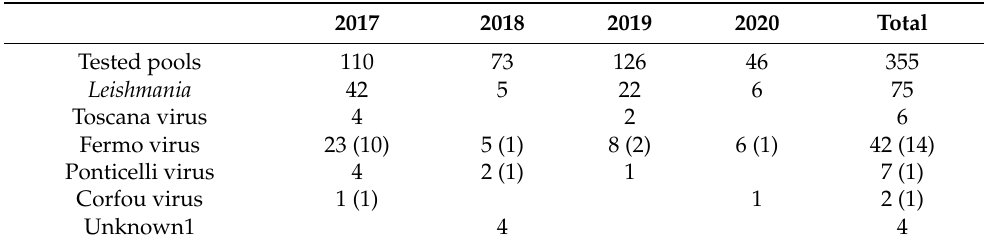
Table 2. Leishmania spp. and phleboviruses detected in double-tested pools by year of surveillance. Phlebovirus-positive pools that also tested positive for Leishmania spp. are shown in